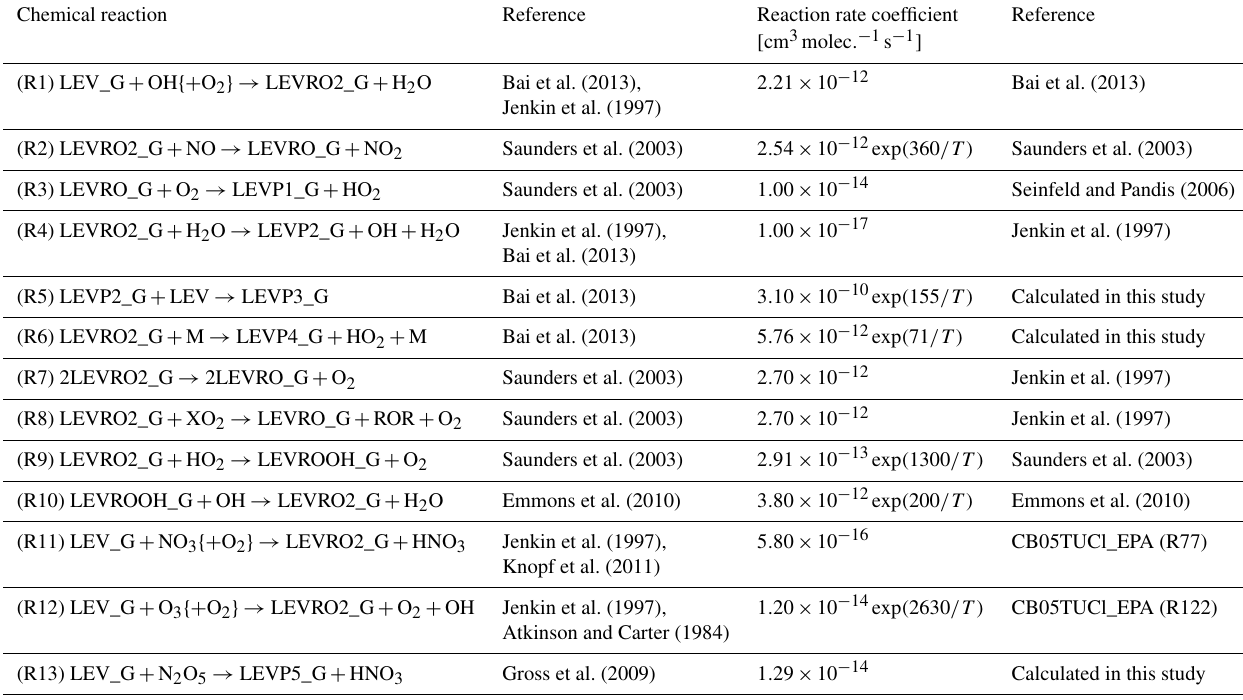
Table 1. Homogeneous gas-phase